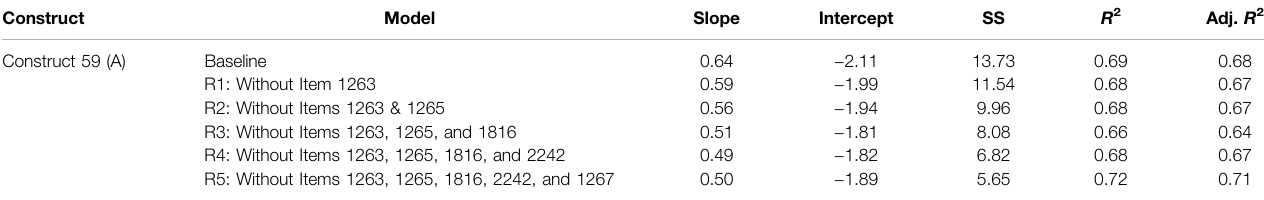
TABLE 5 | Regression equations, R 2 and sum of squares for sequential regression